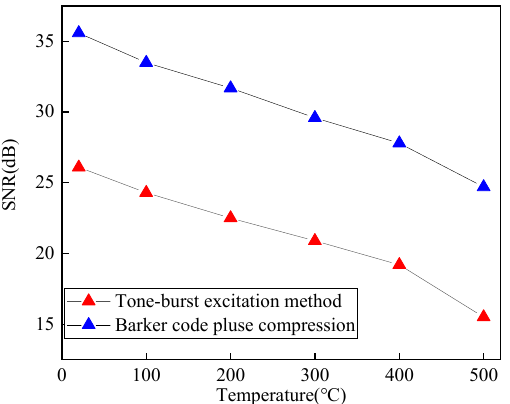
Figure 29. SNR variation curve of the crack-reflected wave with temperatures in carbon steel forg- ings.